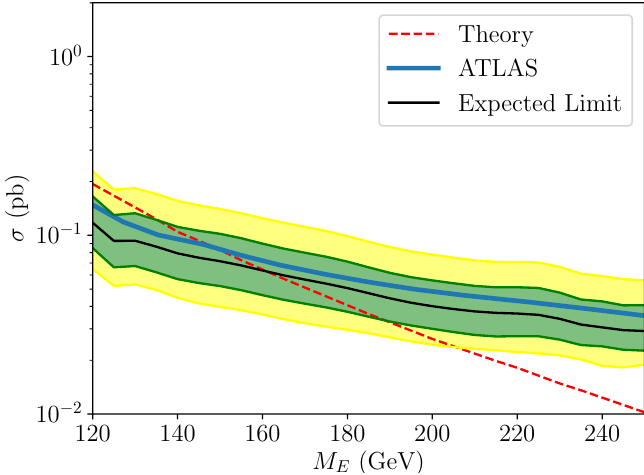
Figure 2 . Comparison of our recast of the VLL search with the ATLAS collaboration results. We show the case in which the off- Z lepton is an electron, with the 1 (green) and 2 (yellow) sigma exclusion region from our simulation together with the expected limit as reported in the ATLAS search (solid blue) and the theoretical pair production cross section (dashed red). The branching fractions are fixed to those of a VLL singlet with SM only decays (as a function of its mass). only region, in which exactly 3 leptons are identified with no pairs of jets satisfying the previous condition on their invariant